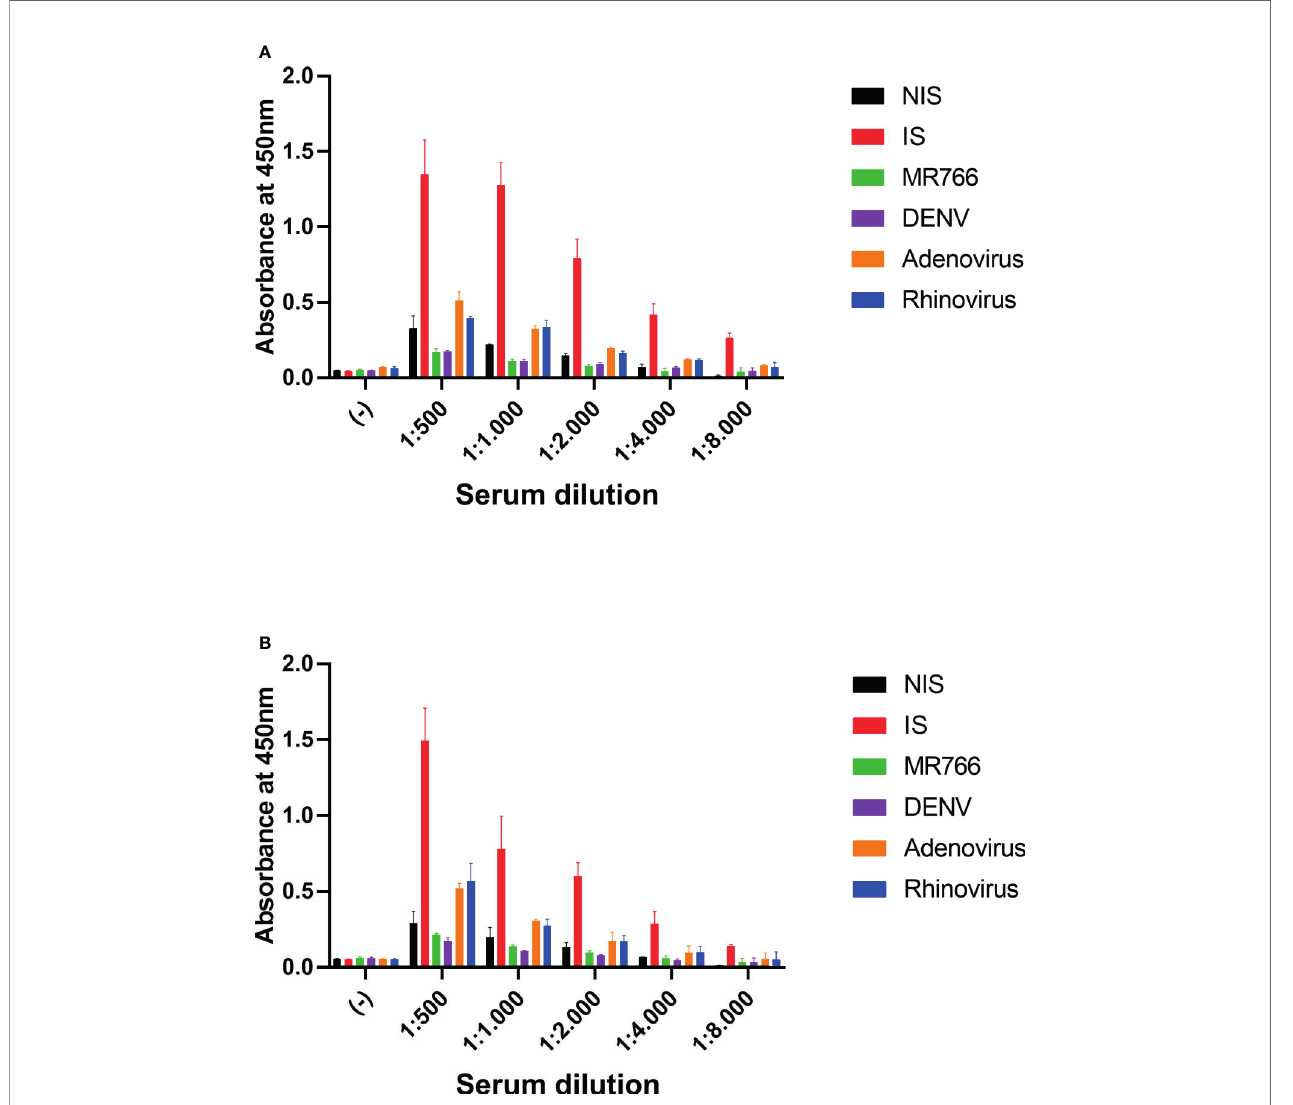
FIGURE 2 | Cross reactivity assay. Serum samples at indicated dilutions were incubated with antigen-coated plates. (A) Plates were coated with N protein. (B) Plates were coated with 3CL protein. ( − ) negative control, no serum; 1:500, 1:1,000, 1:2,000, 1:4,000, and 1:8,000: serum dilution; NIS, non-immune serum; IS, immune serum of mice immunized with inactivated SARS-CoV-2; MR766, immune serum of ZIKV challenged mice; DENV, immune serum of DENV challenged mice; Adenovirus, immune serum of Adenovirus challenged mice and Rhinovirus: immune serum of Rhinovirus challenged mice. Two-way ANOVA, p < 0.05 for IS against NIS in all dilutions, but 3CL 1:8000. The serum of fi ve animals was pooled for each